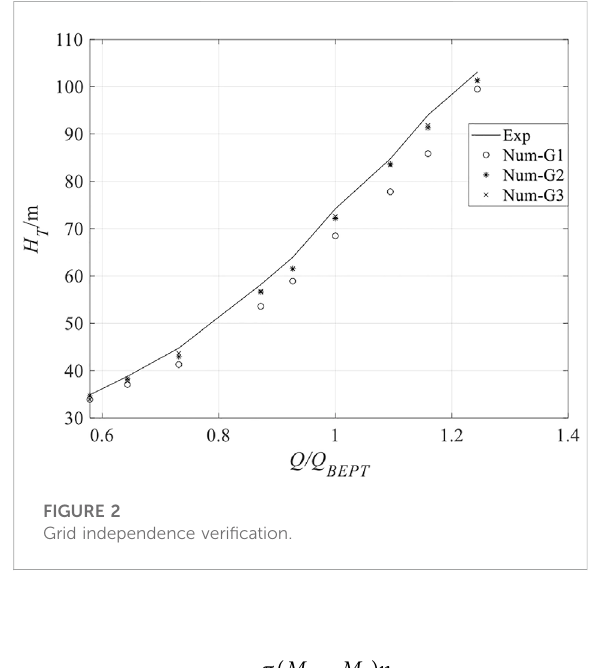
FIGURE 2 Grid independence veri fi